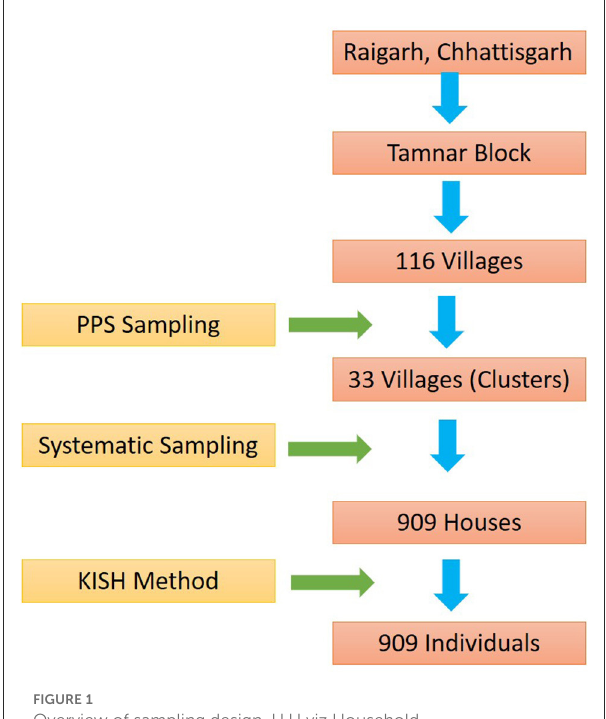
FIGURE1 Overview of sampling design. H.H viz